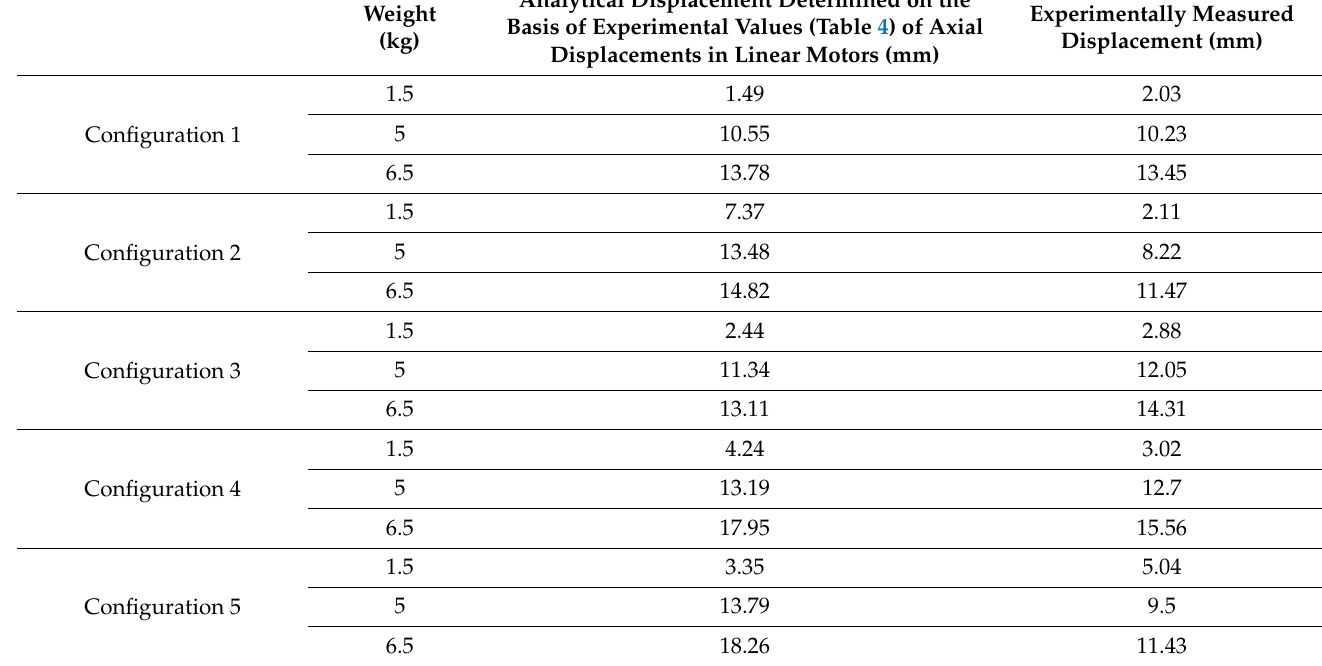
Table 6. Effector displacement calculated based on experimentally determined angles of the robot arms. All calculations were performed based on rigid solid rotations of the robot